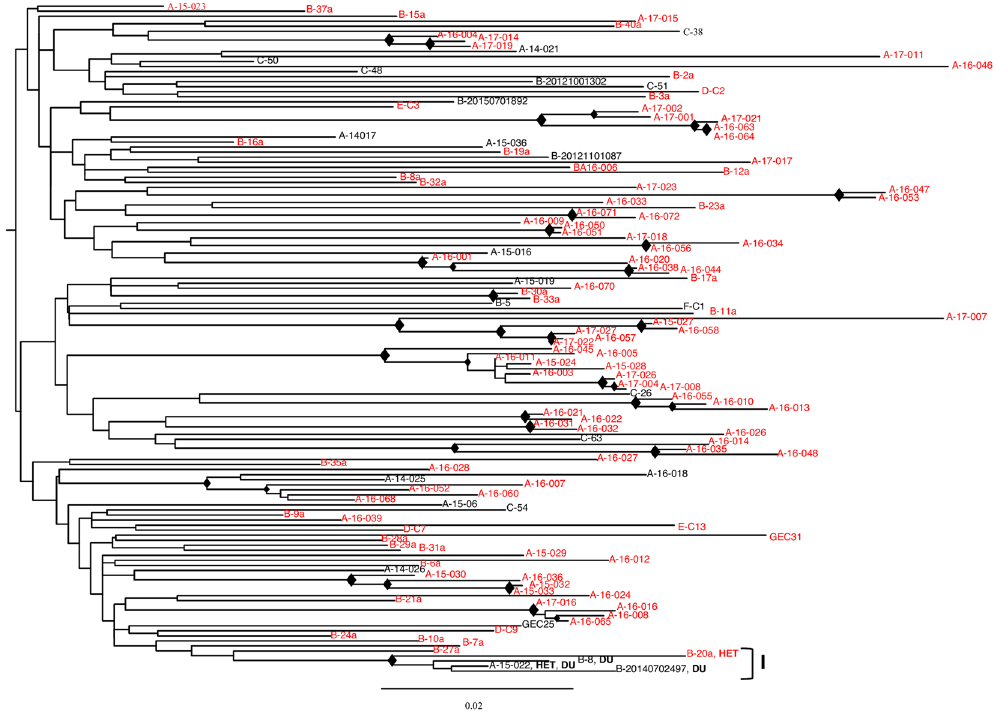
Figure 4. Clustering analysis of HIV-1 sequences from 108 Italians and 25 immigrants infected by HIV-1 subtype B, according to HIV risk behaviour and demographical data. ML trees are shown. The diamond ( ♦ ) located in the nodes represents significant statistical support for the clade subtending that branch (bootstrap support > 70%). Roman numbers indicate clusters. Names include the city one-letter code, and an internal patient code. The risk factor (DU: Drug User; HET: Heterosexual) is reported only for patients included in a cluster. Italian natives are indicated in red, immigrants in black. The scale bar indicates 0.02 nucleotide sequence